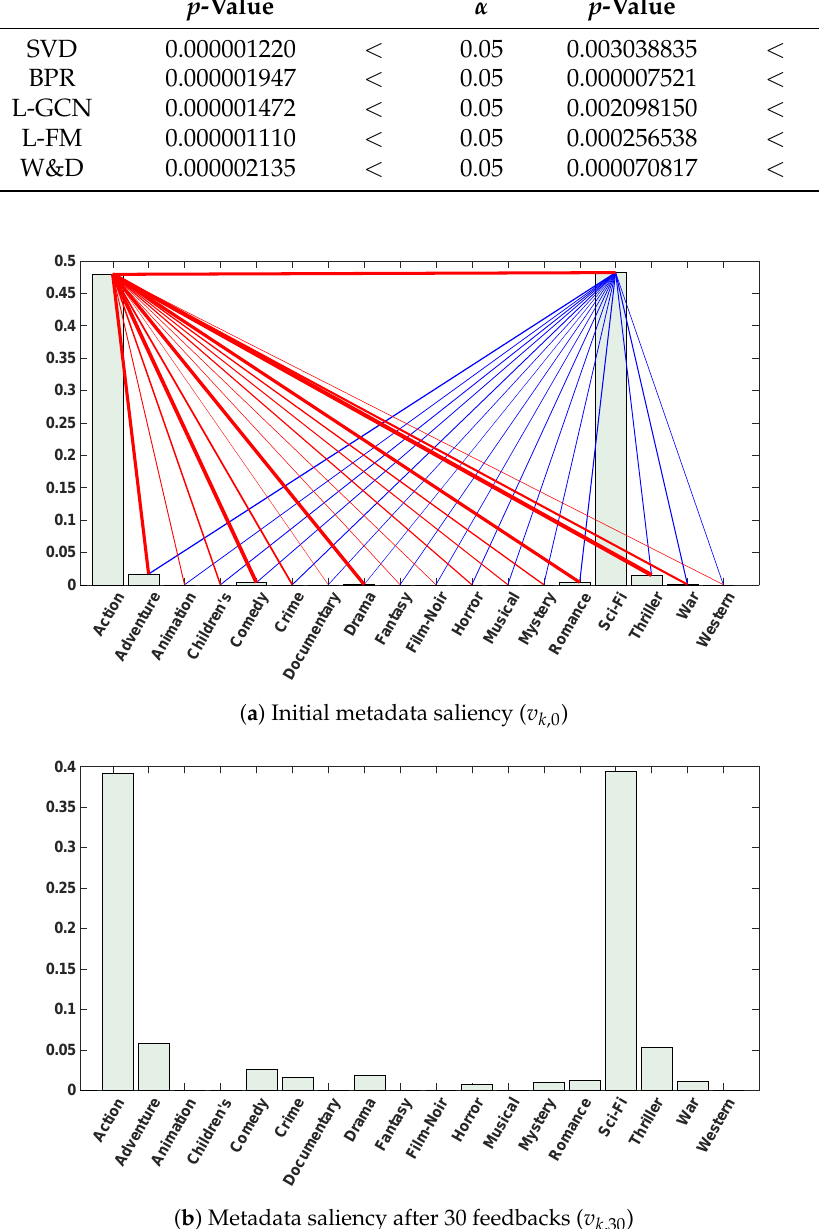
Figure 7. The effect of implicit feedback on metadata saliency (MovieLens